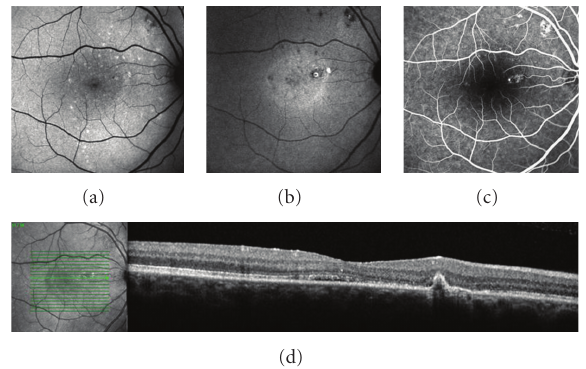
Figure 2: Patient with 9 months of history of CSC in the right eye. (a) Standard FAF, showing mottled hyperFAF spots; (b) NIA, pre- senting macular and supratemporal to the optic disk hypofluores- cent points—the macular spot surrounded by a ring of hyperAF, corresponding exactly with the PED in (d); (c) spots of leakage in the angiography; (d) SD-OCT exhibiting the PED.